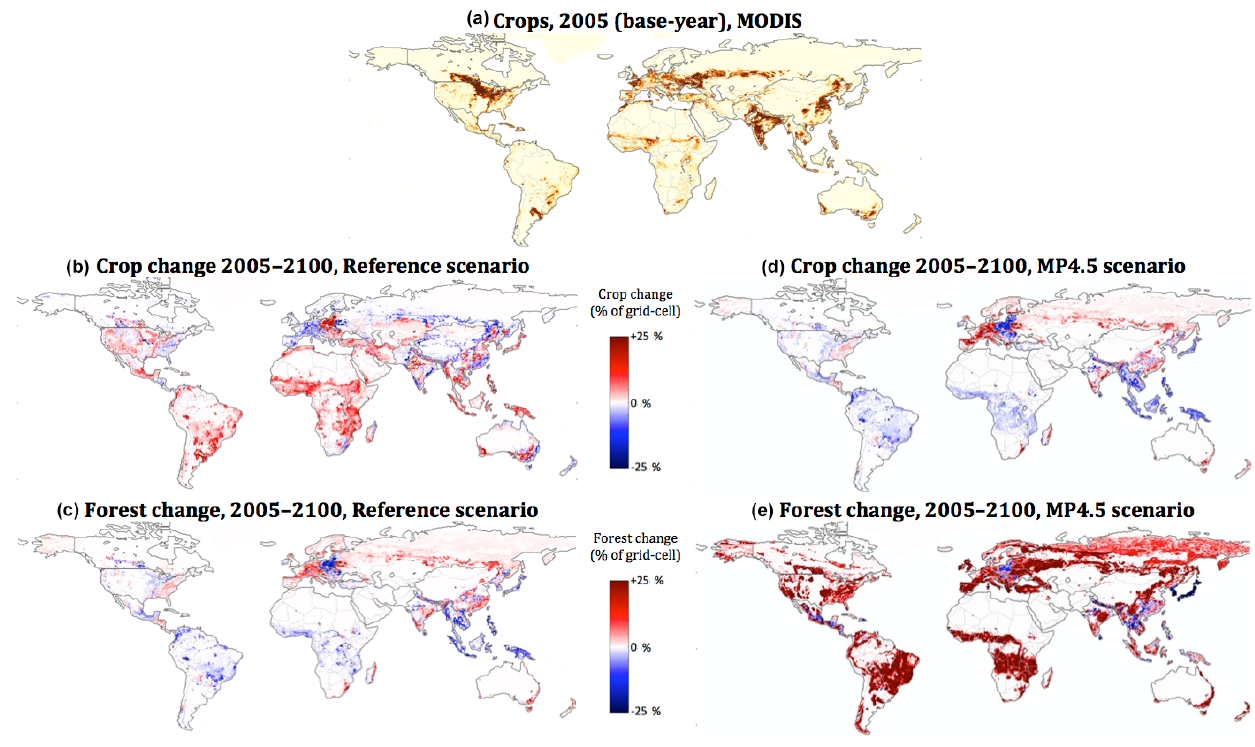
Figure 7. Downscaled GCAM LULC from the reference and MP4.5